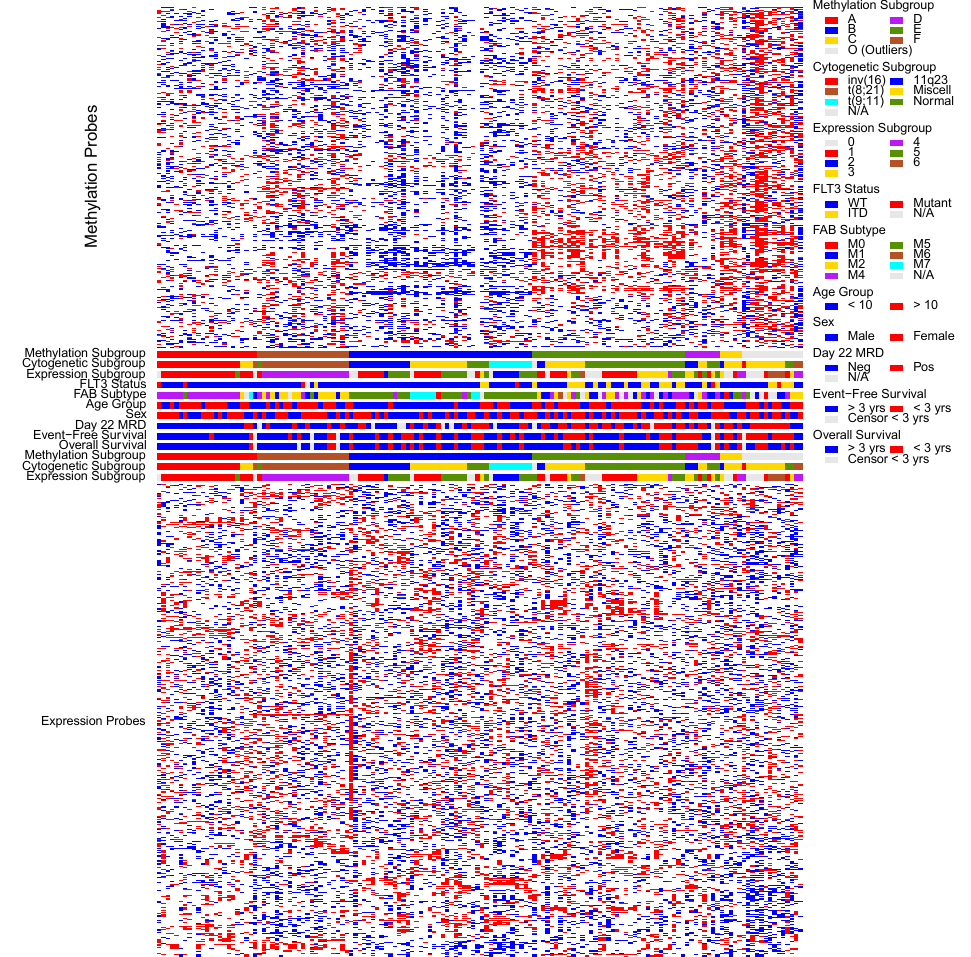
Figure 1. Heatmap representing top results for the unsupervised hierarchical clustering of methylation (500 probes) and expression (700 probes) probes representing different clusters across AML patients from AML02 clinical trial. For methylation, red depicts hypermethylation and blue corresponds to hypomethylation; for expression heat map at the bottom of the figure, red represents high expression and blue represents low expression. Cytogenetic features (as per color code on right), FLT3 status (FLT3-WT = blue; FLT3-ITD = yellow, FLT3-Mutation = red, FLT3-status not available = grey), FAB subtype (as per code on right); age group ( < 10 years = blue, > 10 years = red), sex (male = blue, female = red); Day 22 MRD after induction 1 (negative = blue, positive = red, not available = grey), 3 year event free and 3 year overall survival are shown corresponding to the key on the right. For all the features, grey = data not available or censored < 3 year for survival